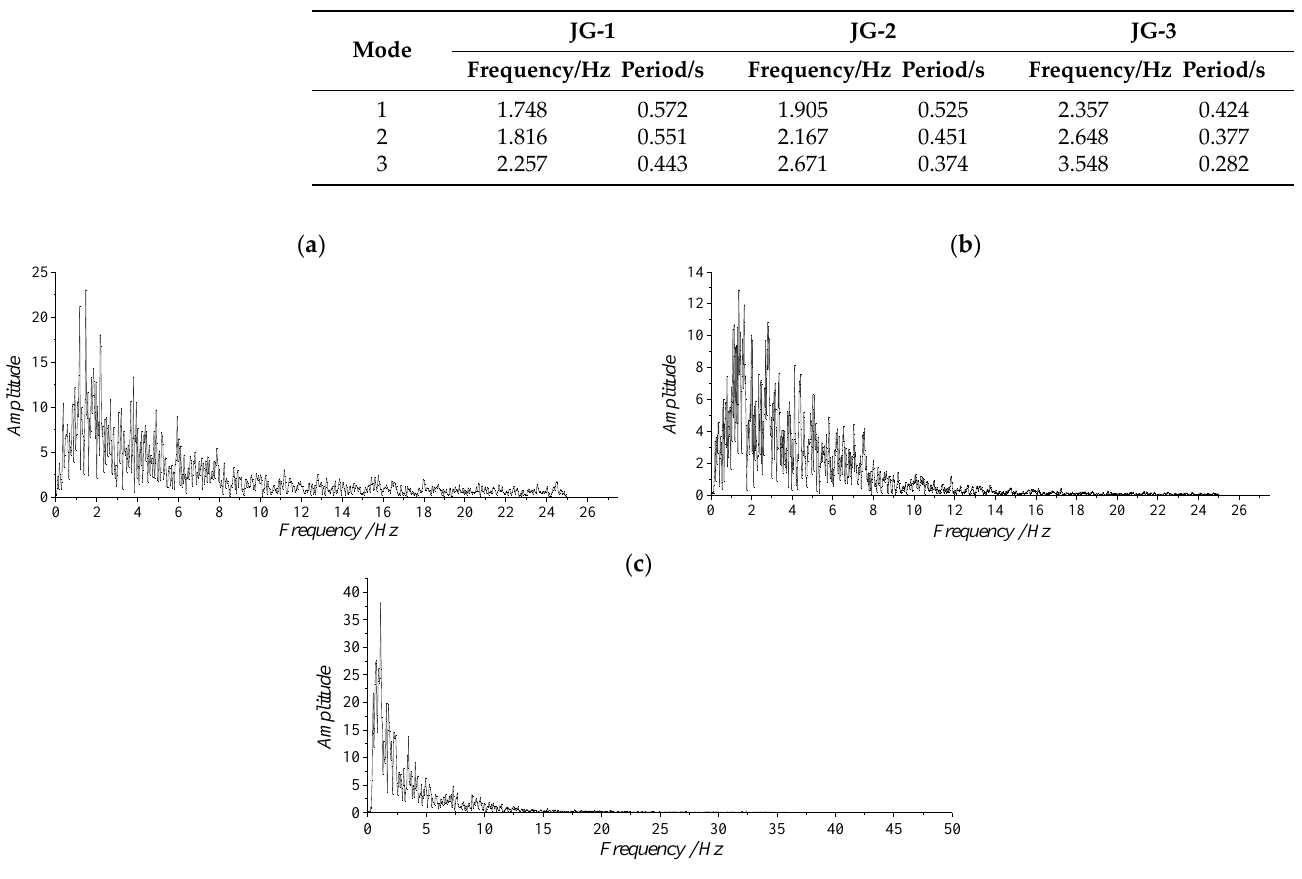
Figure 17. The Fourier spectrum of three waves. ( a ) EL Centro wave; ( b ) Taft wave; ( c ) TJYY wave.